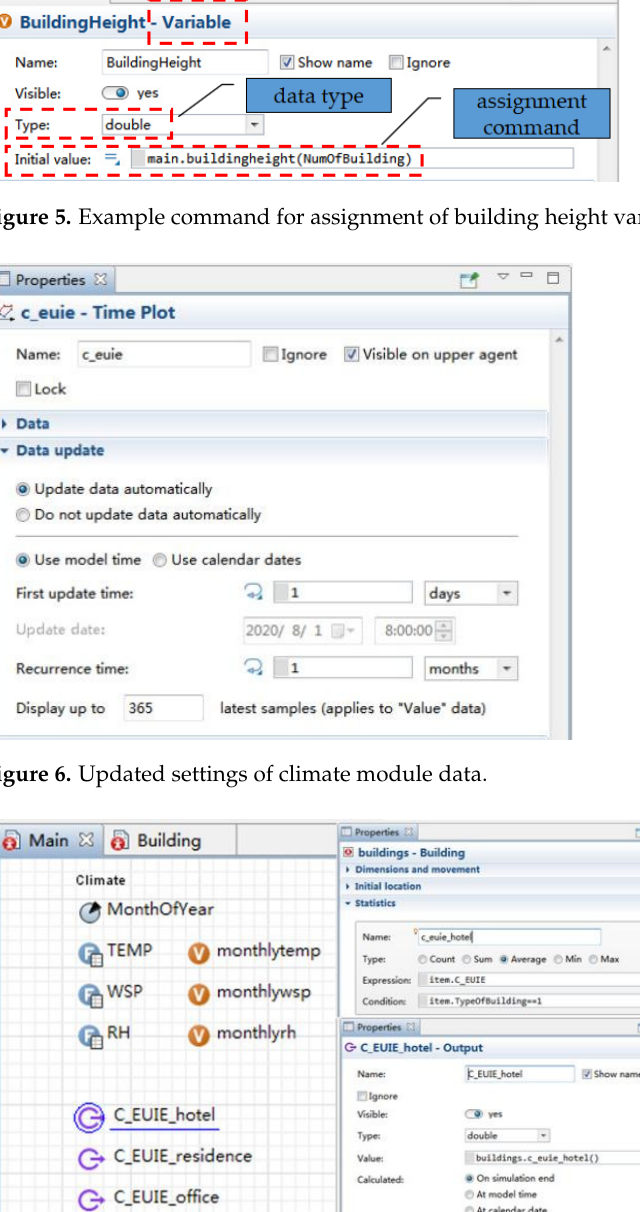
Figure 7. Simulation output of energy consumption under the climate module on the main panel.